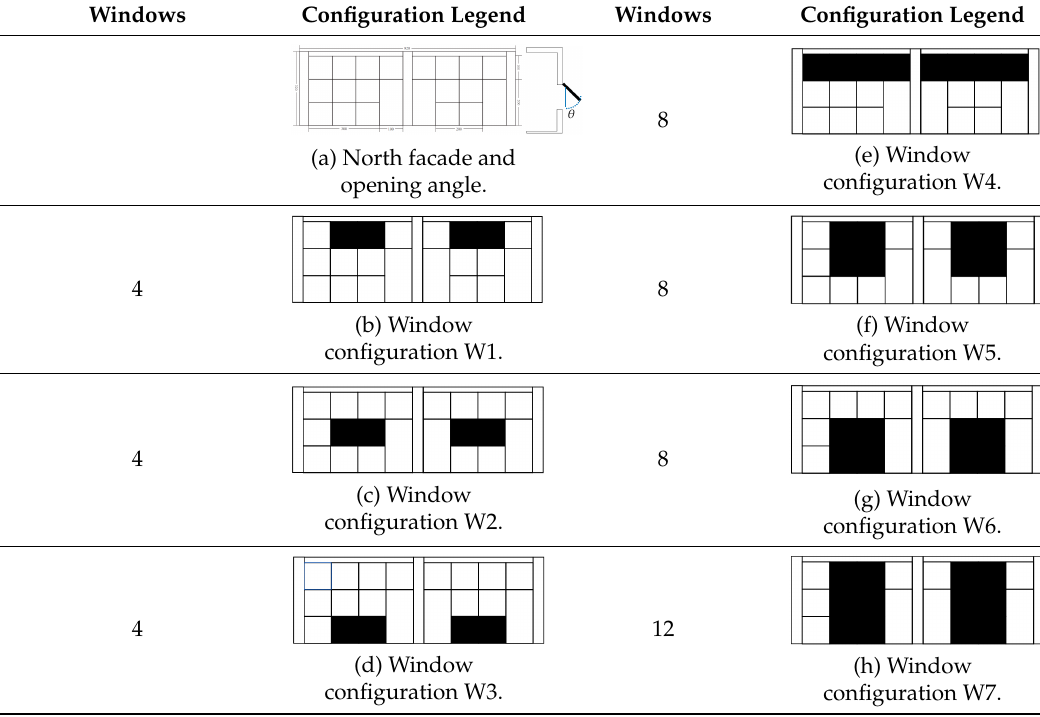
Table 1. Quantity and position of installed awning windows (north facade).